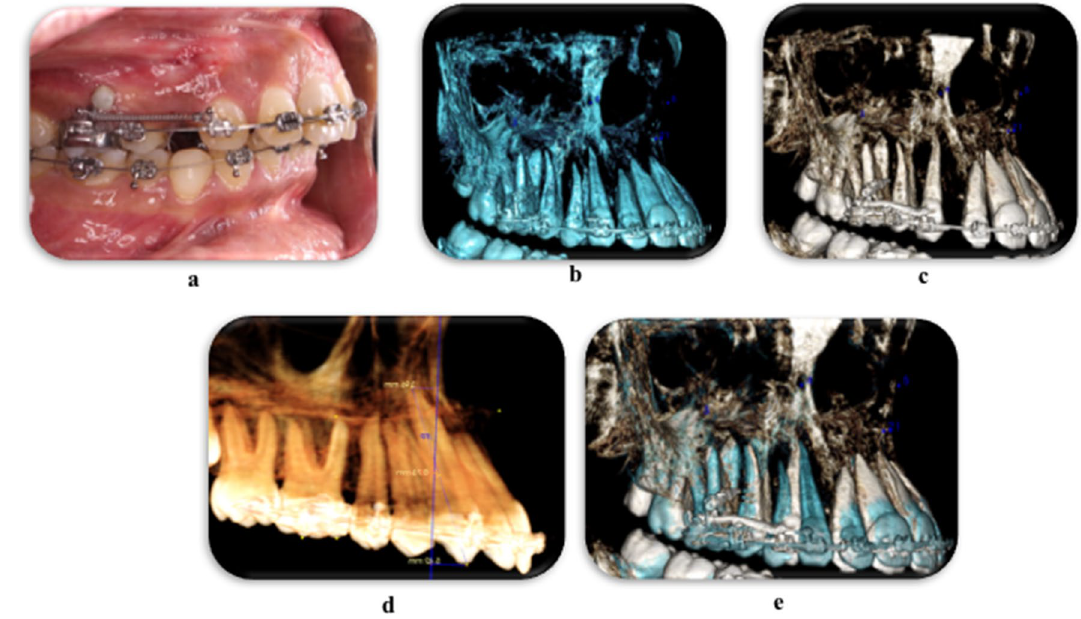
Figure 1. (a) Maxillary canine retraction using conventional mechanics, (b) maxillary arch CBCT before canine retraction, (c) maxillary arch CBCT after canine retraction, (d) distances traveled by canine cusp tip and root apex on CBCT, (e) superimposed CBCTs before, and after canine retraction showing the amount of canine tipping.